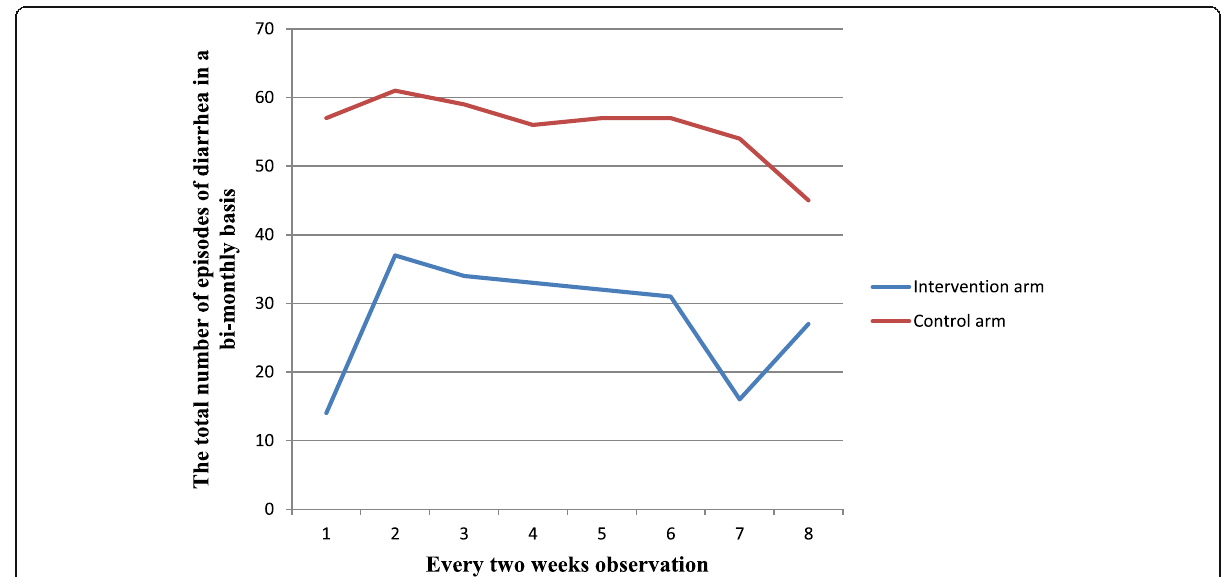
Fig. 2 Total number of episodes of diarrhea recorded at 2-week observations for intervention and control groups in rural Dire Dawa, eastern Ethiopia, 2019